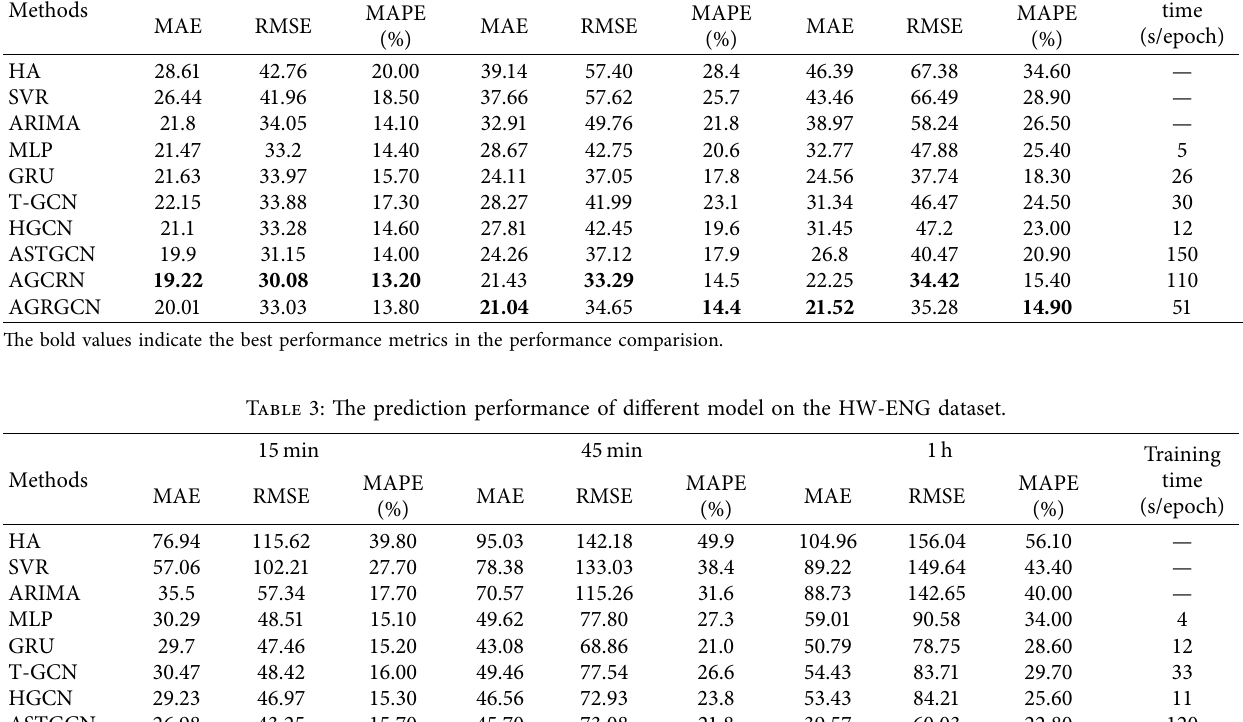
Te bold values indicate the best performance metrics in the performance